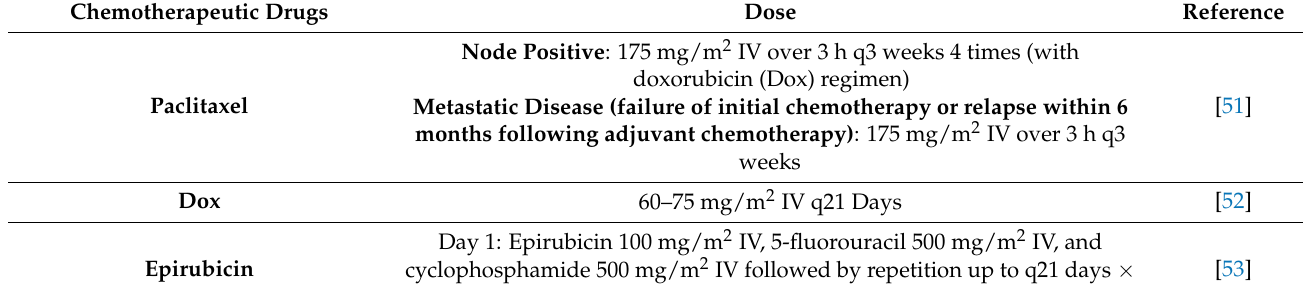
Table 2. Marketed chemotherapeutic agents with their doses for breast cancer treatment.